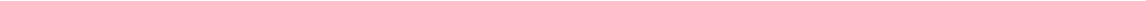
Fig. 4 TAGK2-dependent Tyr phosphorylation of GARU represses GARU – GID1A interaction. a Diagram of the structure of GARU (upper) and multiple sequence alignment of GARU protein in different species (lower). b , c In vitro kinase assay of GARU and its mutants by TAGK2 and TAGK3. GARU (WT) and GARU- Δ C mutant ( Δ C) ( b ) or GARU Y321F mutant (Y321F) ( c ). Tyr phosphorylation (pY) was detected by immunoblotting using anti-phospho-Tyr antibody (4G10). d , e In cell phosphorylation analysis of GARU mutants by Phos-tag SDS-PAGE. AGIA-GARU C190/193S mutant (CS) or AGIA-GARU C190/ 193S/Y321F mutant (CS/Y321F) was co-expressed with TAGK2-3 × FLAG (wild-type, WT; kinase dead, D) in tagk2 protoplasts ( d ). V5-GARU C190/193S mutant (CS) was co-expressed with TAGK2-3 × FLAG in the presence (+) or absence ( − ) of 1 μ M GNS ( e ). f GARU – GID1A interaction analysis by pull- down assay. HA-GARU (prey) was incubated with FLAG-TAGK2 or TAGK3 (wild-type, W; kinase dead, D), and then incubated with GID1A or PYR1 (bait). V5-tagged proteins were immunoprecipitated (IP) with anti-V5 antibody, and analyzed by immunoblotting (IB) using anti-HA antibody. g GARU – GID1A interaction analysis by AlphaScreen. FLAG-GARU and its mutants ( Δ C, Y321F, Y321D, and Y321E) were incubated with TAGK2-His (wild-type, WT; kinase dead, D), and then incubated with biotin-GID1A. GARU – GID1A interaction was analyzed by AlphaScreen (upper), and Tyr phosphorylation (pY) of GARU was analyzed by immunoblotting using anti-phospho Tyr antibody (4G10, lower). Relative AlphaScreen (AS) signal was quanti fi ed as the PPI signal value ratio of FLAG-GARU WT (pre-incubated with TAGK2 KD )-biotin-GID1A. Data are means ( ± s.d.) of three independent experiments ( n = 3). h , i In cell co-expression analysis of GID1A-AGIA with V5-GARU (WT) or its mutants (Y321F, Y321E, and Y321D) in the absence ( h ) or presence ( i ) of MG132. j Immunoblot analysis of endogenous GID1A/C in Col-0, tagk2 , TAGK2 WT -OX1, TAGK2 KD -OX1, and garu-1 . Seedlings were treated with 300 µ M CHX and 1 µ M GNS. Relative GID1A/C protein level was calculated as the signal intensity ratio of the without GNS treatment. Data are means ( ± s.d.) of four independent experiments ( n = 4). Statistically signi fi cant changes compared with in the absence of GNS are indicated ( *P < 0.05, as determined using two-tailed Student ’ s t